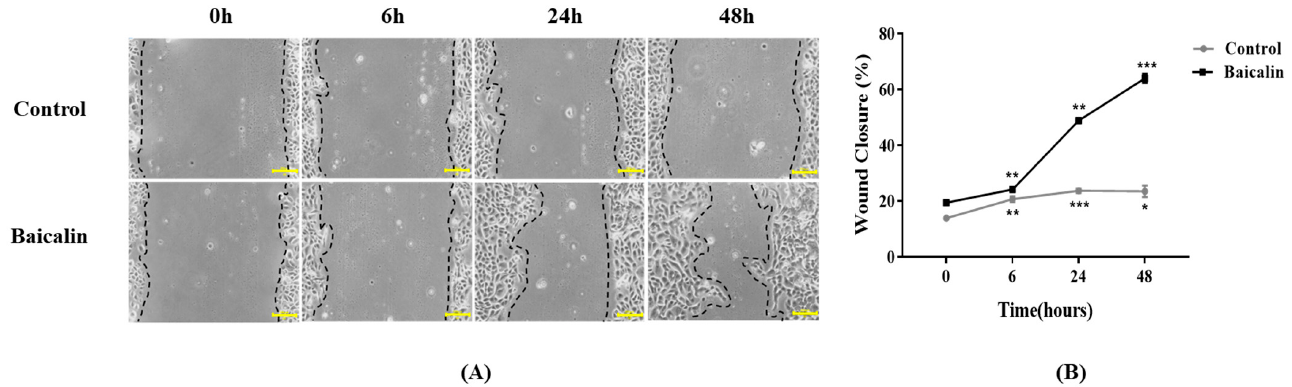
Figure 1. Baicalin enhances the rate of wound closure by human epidermal keratinocytes (HEKs). ( A ) Images of HEK scratch assays immediately after the scratch was made and then after 6, 24, and 48 h in the presence of baicalin. There was a significant increase in the extent of wound closure in HEK scratch assays in baicalin compared with that in the control medium at 48 h. ( B ) Statistical analysis of the wound closure area using ImageJ software. All data are expressed as mean ± SD from three independent experiments. * p < 0.05, ** p < 0.01, *** p < 0.001. Scale bar: 200 μ m.